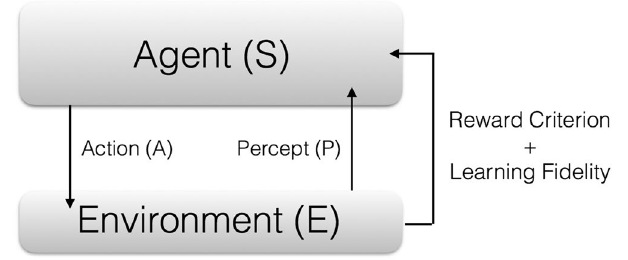
Figure 1. Scheme of reinforcement learning. In each learning cycle, an Agent, denoted by S, interacts with an Environment, denoted by E, realizing some Action (A) on it, as well as gathering information, or Percept (P) about its relation to it. Subsequently, the information obtained is employed in order to decide a strategy on how to optimize the agent, based on a Reward Criterion, whose aim may be to maximize a Learning Fidelity. Afterwards, a new cycle begins. The situation in the quantum realm is similar, and can oscillate between having a quantum version of agent, of environment, or of both of them, as well as interactions between them that can be quantum and/or classical channels with